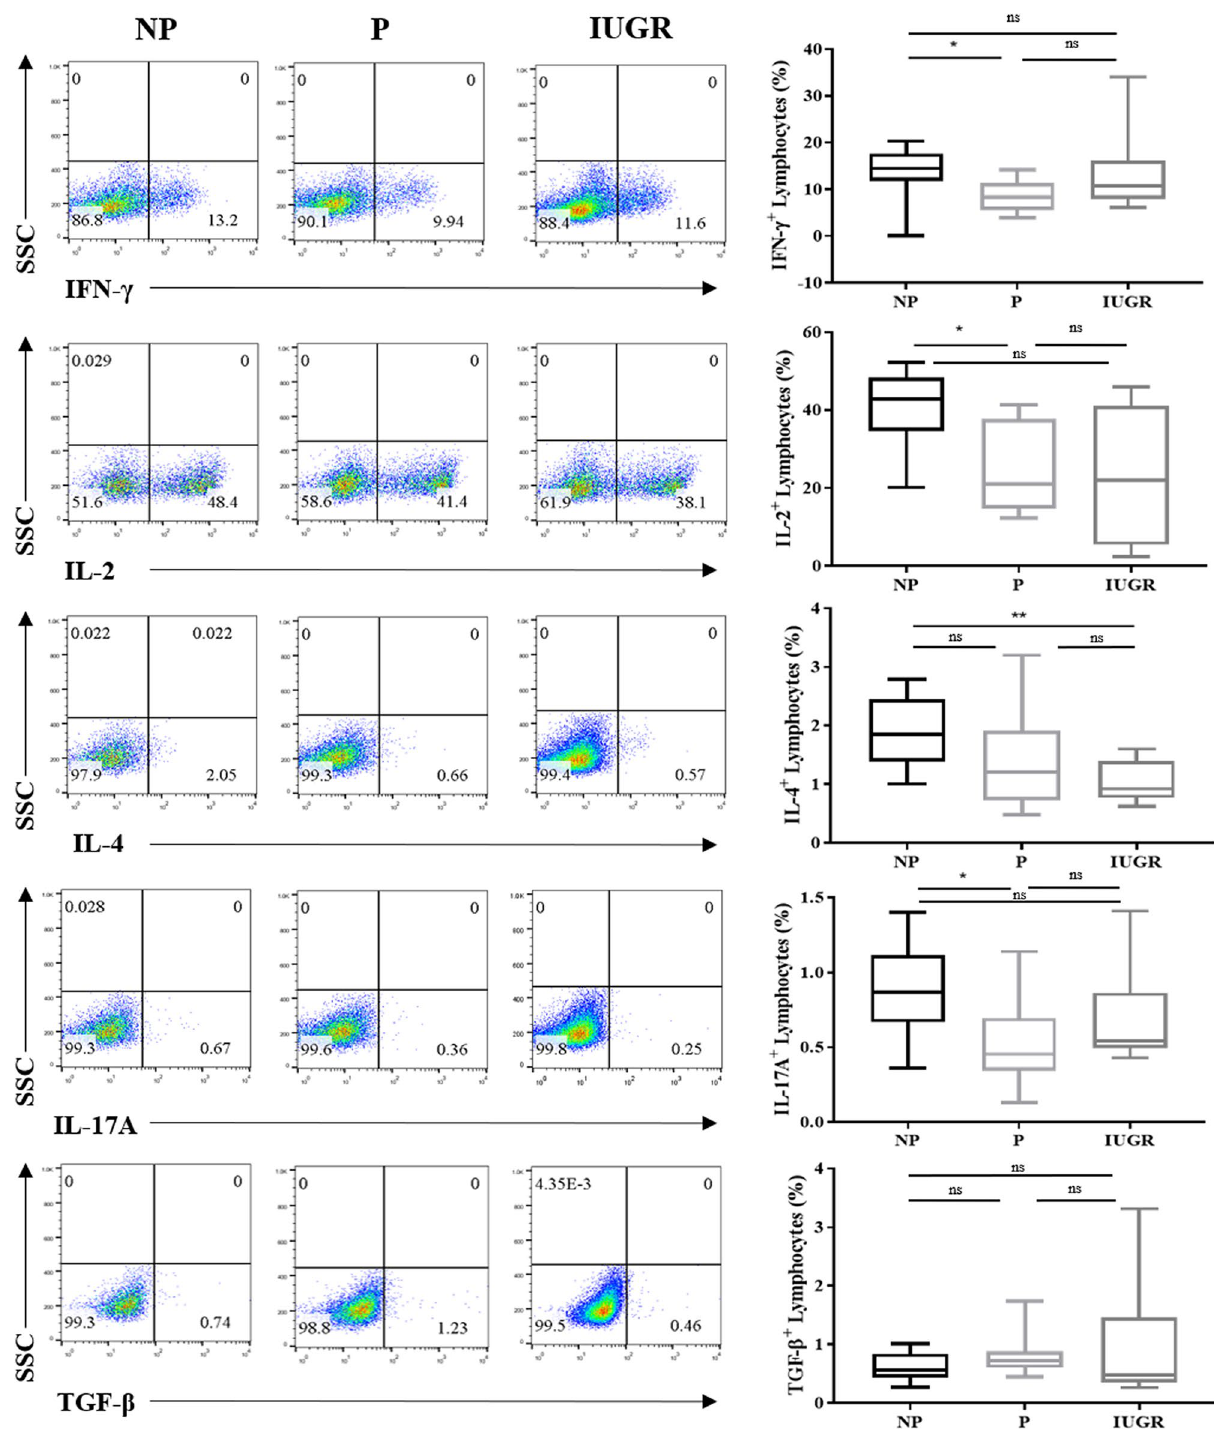
Figure 1. Th1 and Th17 cytokine production is altered in lymphocytes. Representative flow cytometry dot plots of cytokine production in response to PMA/Ionomycin stimulation in lymphocytes from NP, P and IUGR. Box and whisker plots indicate median and IQR of cells expressing IFN-γ, IL-2, IL-4, IL-17A, and TGF-β expression in lymphocytes from NP (n = 10), P (n = 9) and IUGR (n = 8). * p < 0.05, p ** < 0.01, ns = non-significant, determined by Kruskal–Wallis with Dunn’s multiple comparisons test. Flow cytometry data were analysed using the FlowJo Software Version 10 (Becton Dickinson); website: https:// www. flowjo.